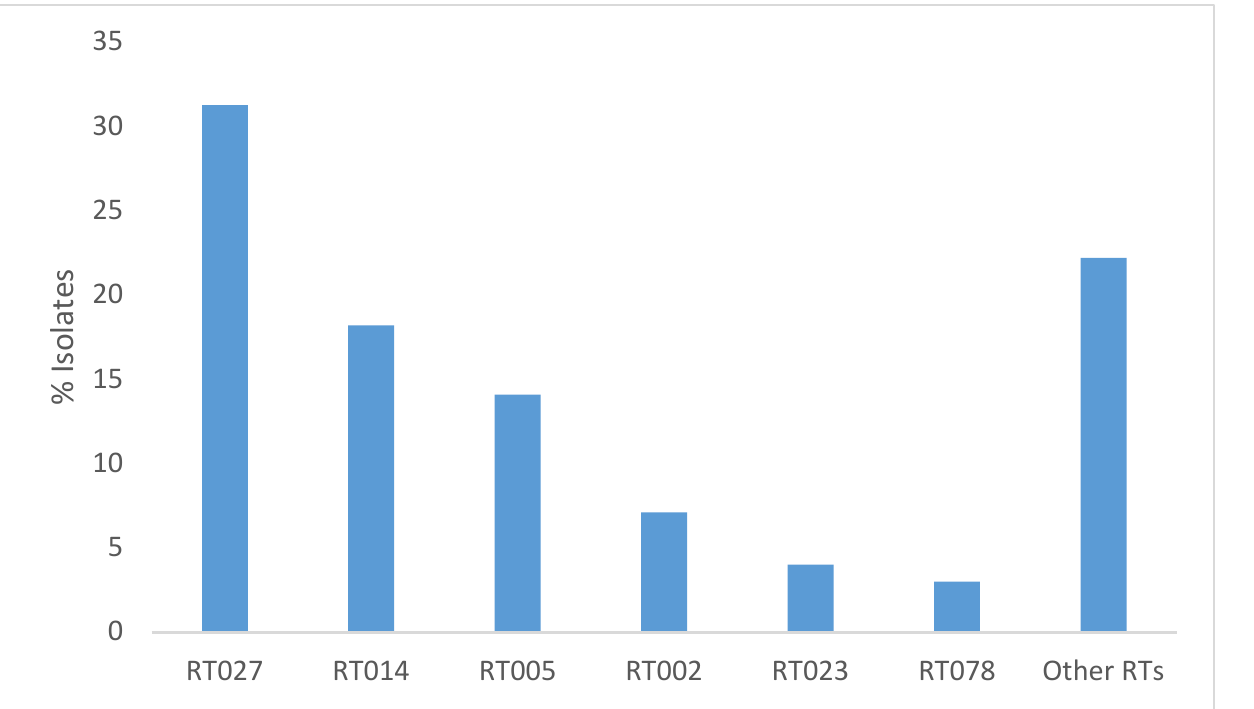
Figure 1. Distribution of C. difficile RTs among clinical isolates from hospitalised patients (n = 99).